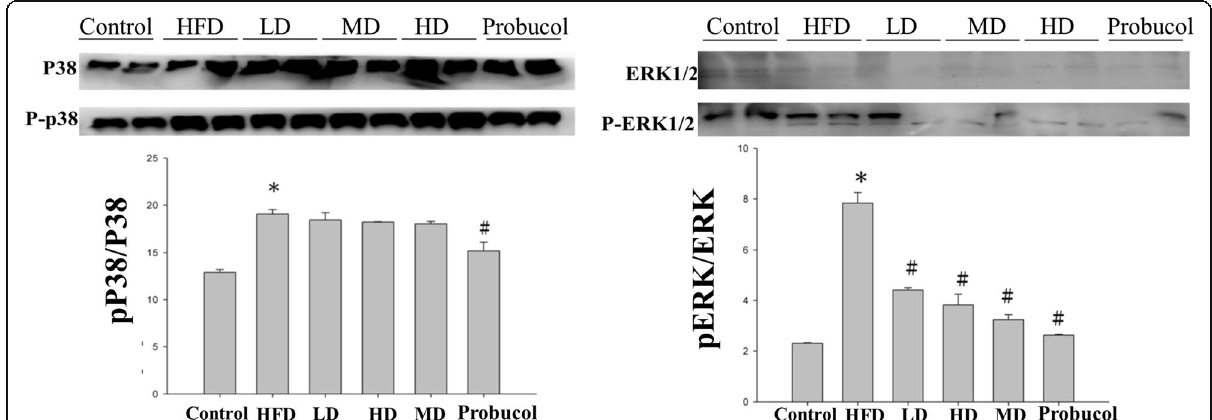
Fig. 5 Expression analysis of MAPK proteins by western blotting. Levels of apoptosis and survival related proteins in the liver sections of Control, HFD fed hamsters (HFD), HFD fed hamsters treated with low dose of APPH (L-APPH), HFD fed hamsters treated with moderate dose of APPH (M- APPH), HFD fed hamsters treated with high dose of APPH (H-APPH) and HFD fed hamsters treated with probucol. n = 5, * p < 0.05 when compared with the Control group; # p < 0.05 when compared with HFD